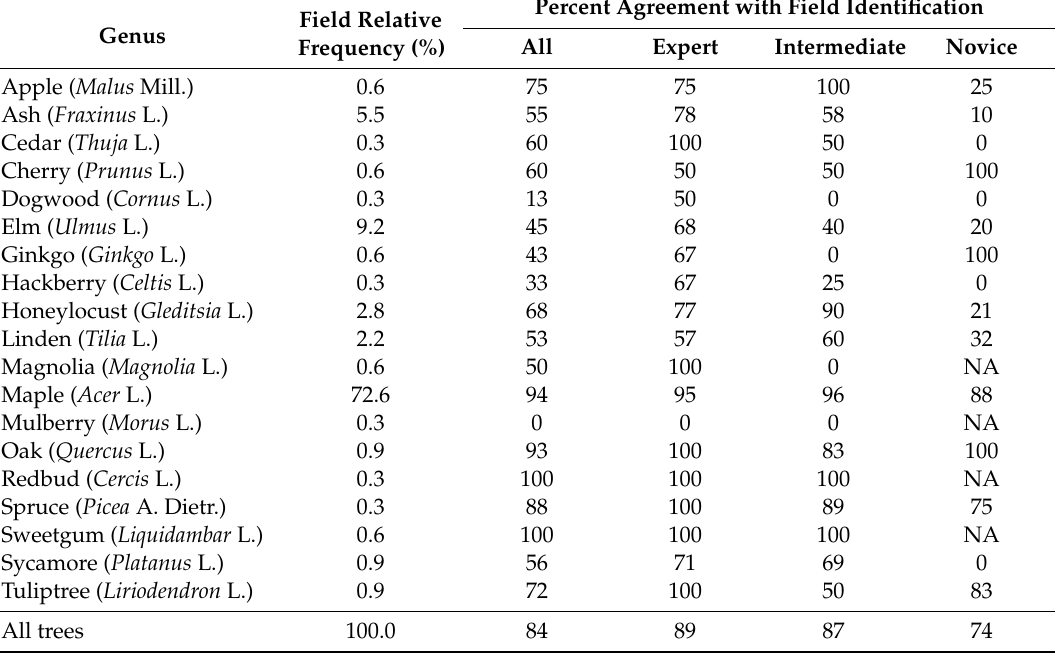
Table 4. Genus identification summarized by analyst expertise. NA indicates the genus was not encountered by an analyst from that group.